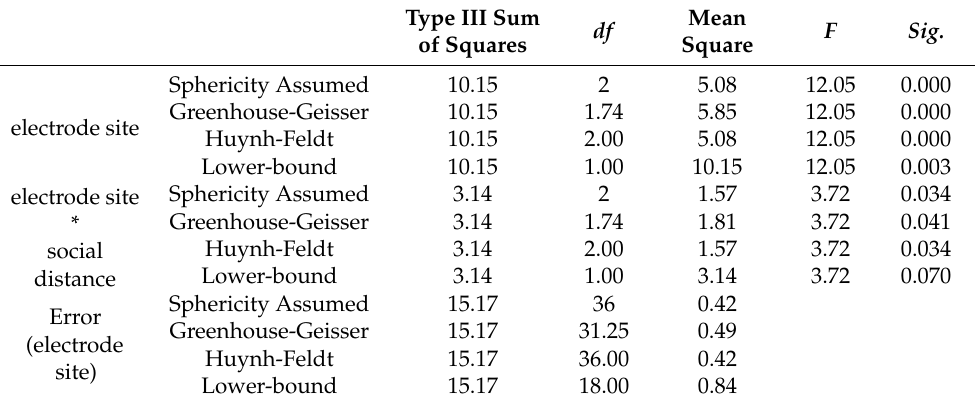
Table 14. Test of Within-Subjects Effects of P2 amplitude (prevention focus).